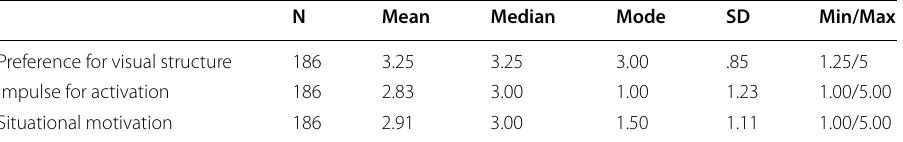
Table 3 Descriptives for dependent